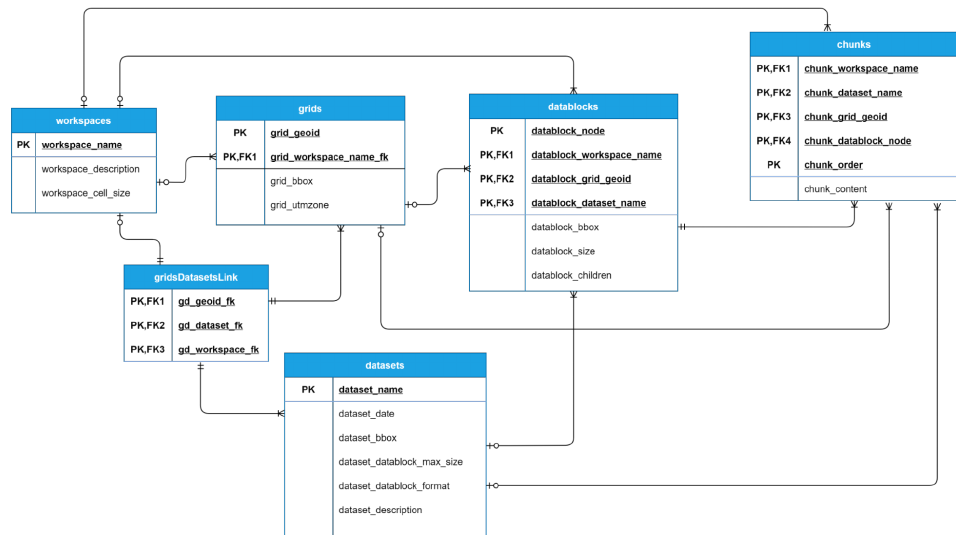
Figure 5. Database design for MySQL and PostgreSQL implementations. PK refers to the primary key and FK to foreign